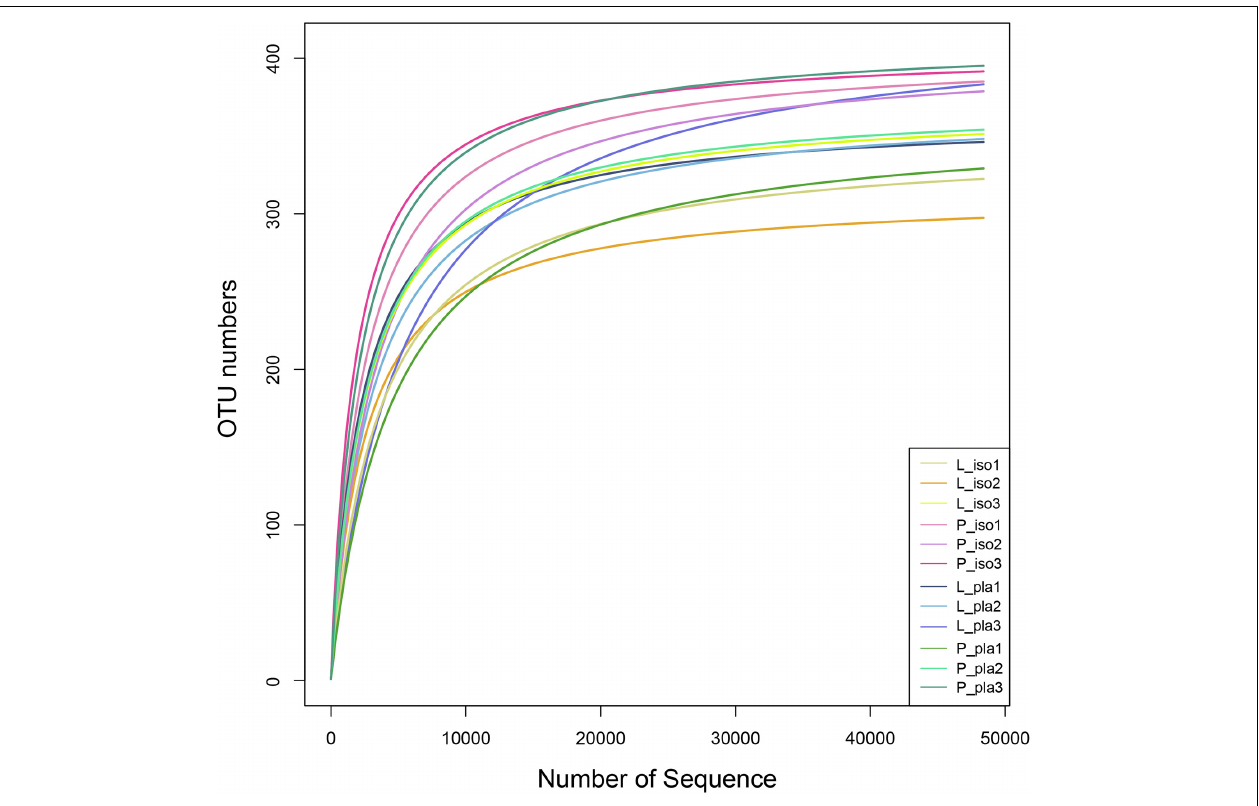
FIGURE 2 | Rarefaction analyses of all samples. Rarefaction curves represented the number of OUT detected in the L-iso group (L-iso 1, L-iso 2, and L-iso 3), P-iso group (P-iso 1, P-iso 2, and P-iso 3), L-pla group (L-pla 1, L-pla 2, and L-pla 3), and P-pla group (P-pla 1, P-pla 2, and P-pla 3). Sequences were clustered at 97% sequence similarity. OTU, operational taxonomic unit. TABLE 2 | OTUs, ACE, Chao 1, Simpson, Shannon, and Good’s coverage for 16s rRNA libraries of all samples.